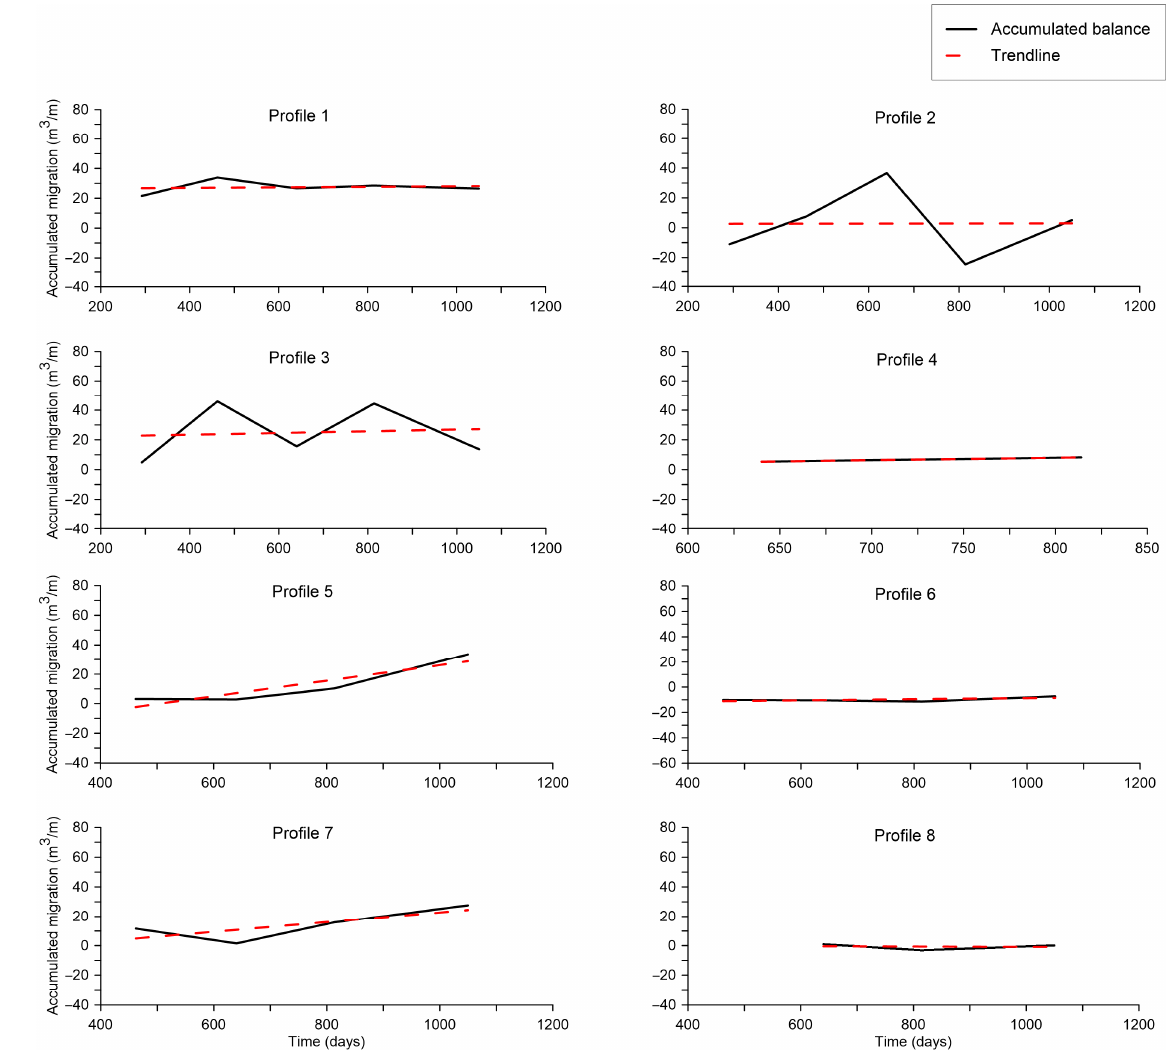
Figure A3. Sedimentary balance for each of the profiles. The dashed red line shows the overall trend.